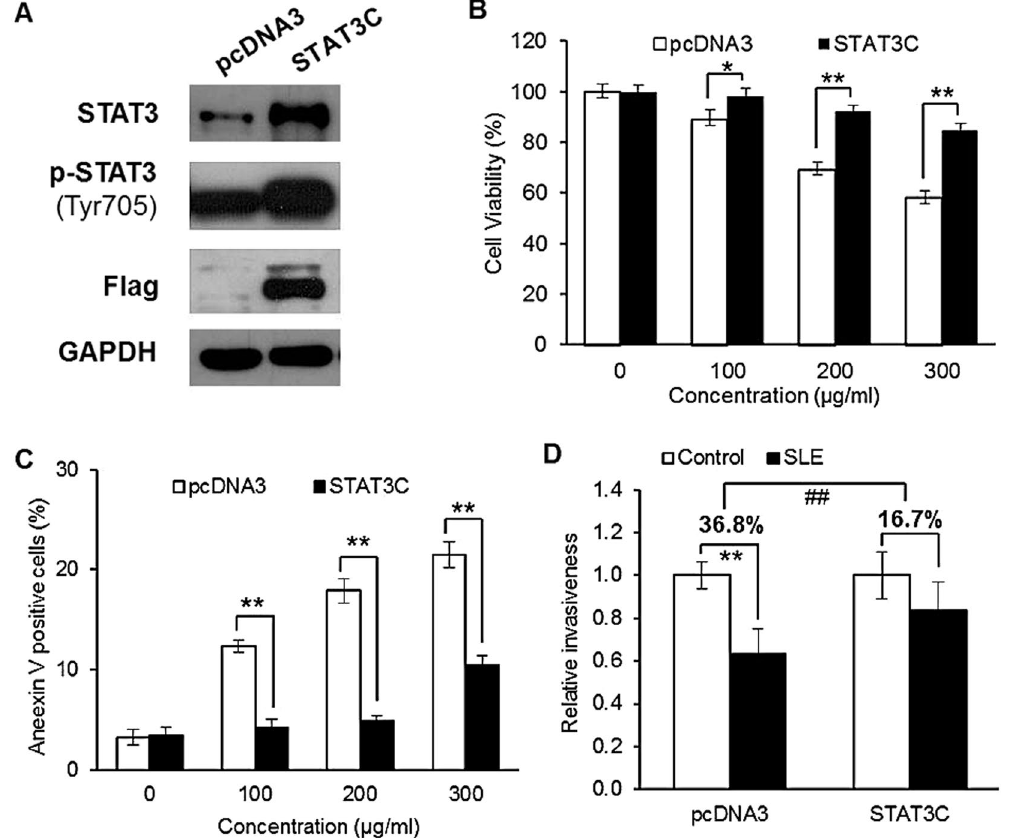
Figure 7. Overexpression of STAT3C in A375 cells diminished the effects of SLE on cell viability, apoptosis and invasion. ( A ) Expression levels of phospho-STAT3 (Tyr705), STAT3 and Flag in A375 cells stably expressing Flag-tagged STAT3C or empty vector (pcDNA3). GAPDH was included as a loading control. Proteins from cultured cells were examined by immunoblotting and cropped blot images were shown. The original uncropped images were shown in Supplementary Dataset. Results shown were the representatives of three independent experiments. ( B ) Effects of STAT3C overexpression on SLE-mediated cytotoxic activity. ( C ) Effects of STAT3C overexpression on SLE-mediated apoptotic effects. In ( B ) and ( C ), A375 cells stably expressing STAT3C or empty vector were treated with indicated concentrations of SLE for 48 h. Cell viability was measured by the MTT assay. Apoptosis was determined by flow cytometric analysis of cells double stained with Annexin V/7-AAD. Data were presented as the mean ± SD of three independent experiments, * P < 0.05, ** P < 0.01. ( D ) Effects of STAT3C overexpression on SLE-mediated inhibitory effects on cell invasion. A375 cells stably transfected with STAT3C or vector were treated with SLE (50 μ g/mL) or vehicle control for 24 h. Cell invasion was determined by matrigel invasion assay. Statistical analyses were performed by ANOVA followed by LSD Test. ** P < 0.01, SLE treatment versus vehicle control treatment. ## P < 0.01, SLE-mediated cell invasion inhibition in A375 cells stably transfected with STAT3C versus that in A375 cells stably transfected with empty